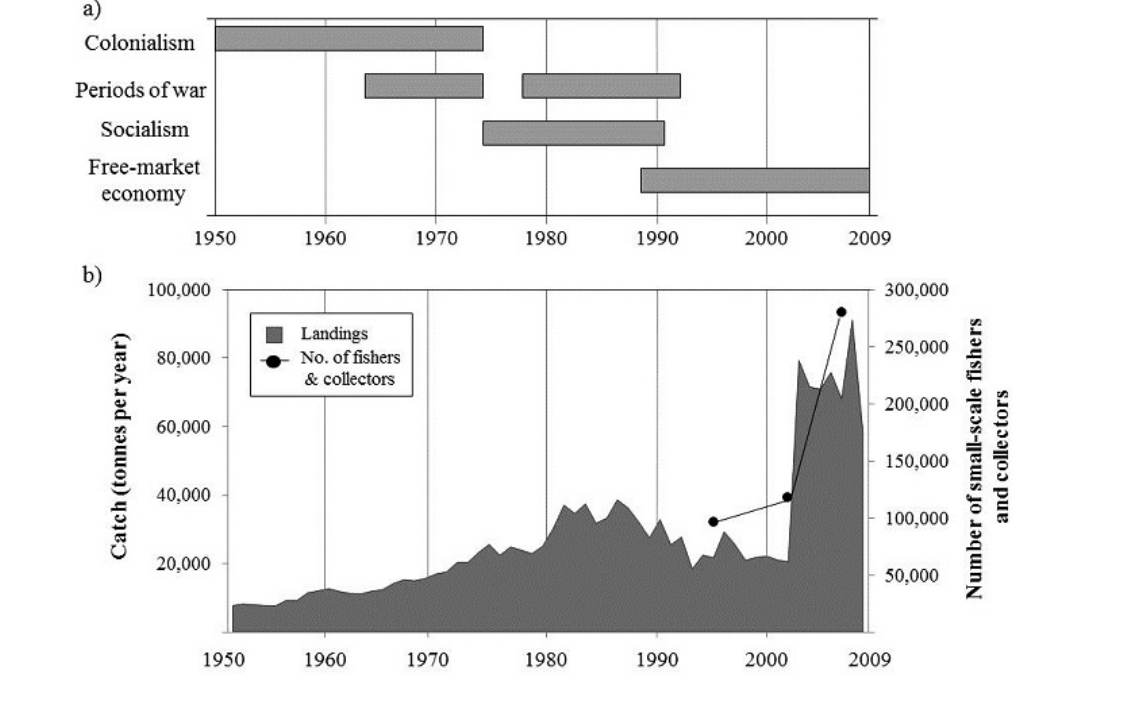
Fig. 2. (a) Periods of socioeconomic change affecting coastal fisheries (adapted from Menezes et al. 2011). (b) Total landings for 1950–2009 (FAO 2011) and total number of small-scale fishers (IDPPE 1998, 2004, 2009) in